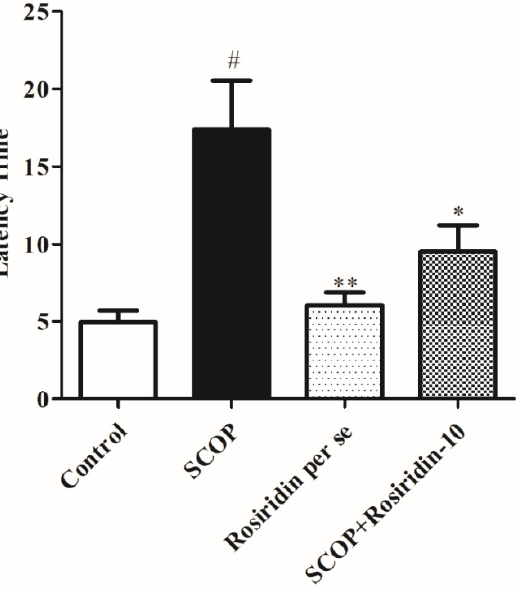
Figure 3. Graph depicts the effect of rosiridin during the Morris water maze retention period. Mean ± S.E.M. ( n = 6). # p < 0.001 vs. normal control, ** p < 0.01 vs. scopolamine control, * p < 0.05 vs. scopolamine control; one-way ANOVA followed by Tukey’s test.